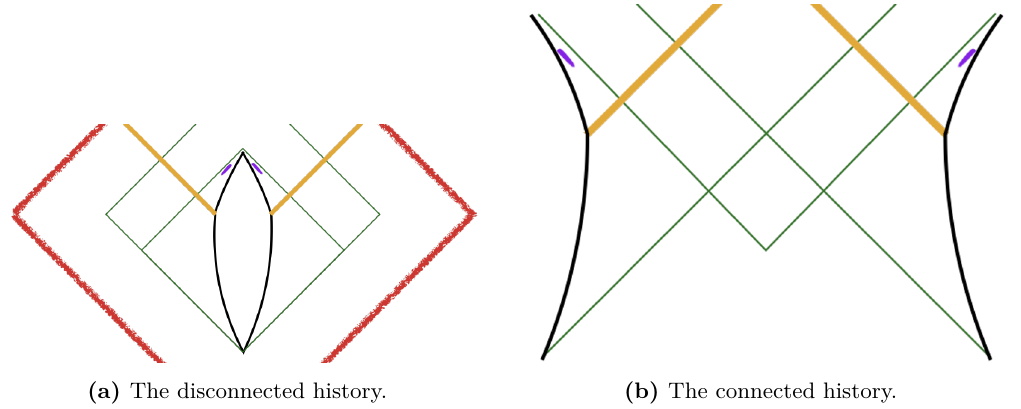
(b) The connected history. Figure 4. The disconnected and connected histories, without the splitting quench. The two boundaries are coupled at u = 0 , which produces a symmetric pair of shocks (orange), kicking the boundary particle outward and moving the future horizon towards the boundary; all causal horizons are green lines. We have also indicated the rough position of the late time QESs. Property Disconnected History Connected History Temperature before quench